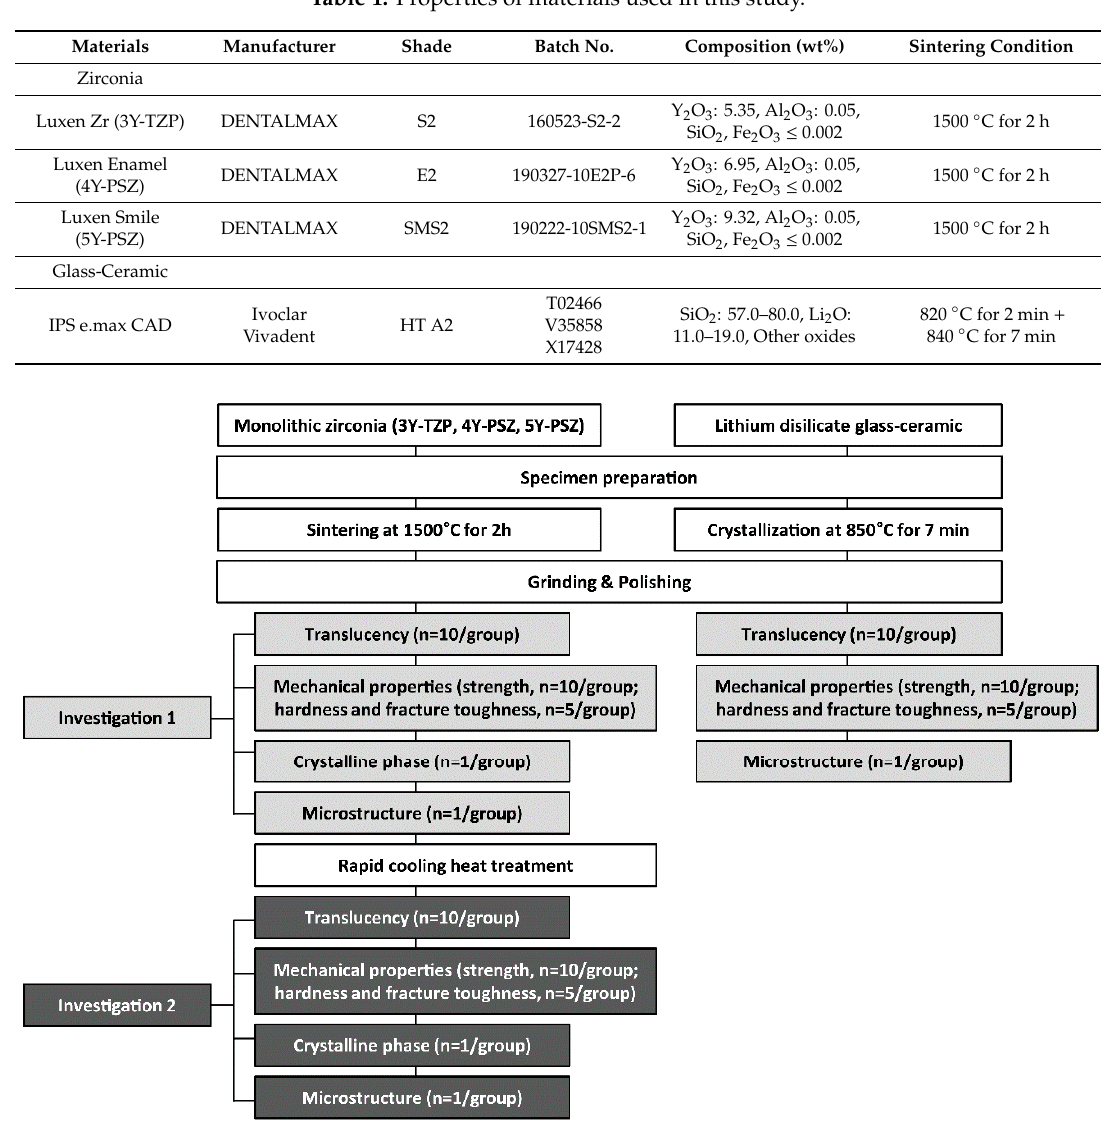
Figure 1. The experimental study design.